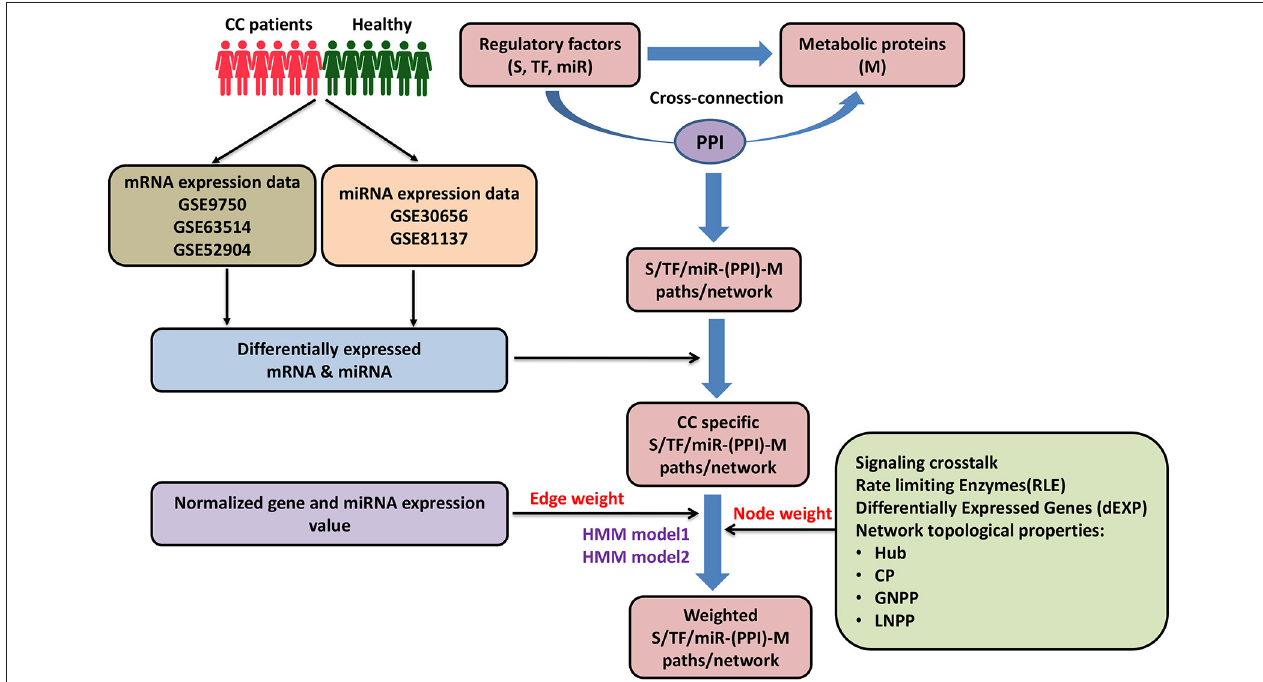
FIGURE 1 | Pictorial workflow of the study. CC, cervical cancer; S, signaling proteins; TF, transcription factor; miR, microRNA; M, metabolic proteins; PPI, protein-protein interactors; CP, central proteins; LNPP, local network perturbing protein; GNPP, global network perturbing